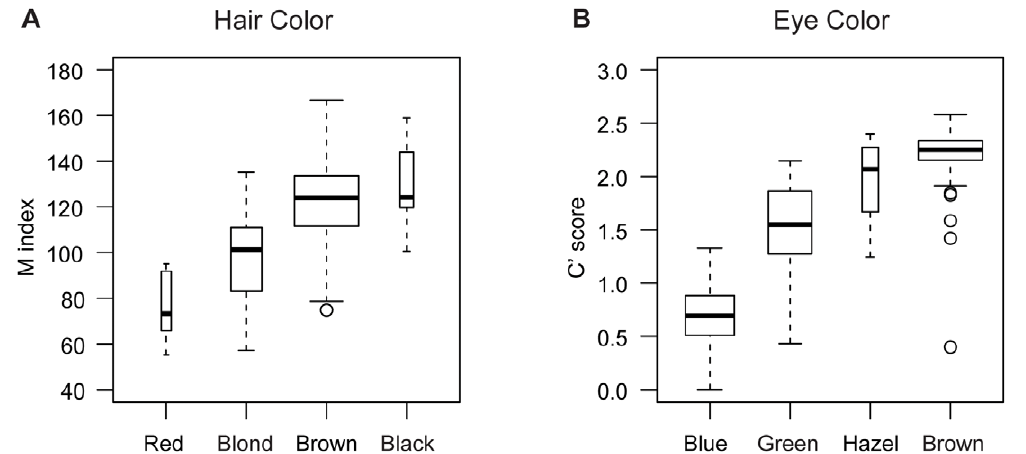
Figure 2. Comparison of measured and self-reported hair and eye color. ( A ) The boxplots of hair pigmentation (M index) binned by self- reported hair color show that there is a good correspondence between categorical hair color and the M index. On average, individuals with red hair color (n=6) have lower M indices than blond individuals (n=58). Individuals reporting brown (n=252) or black (n=11) hair color have the highest M indices. ( B ) Similarly for eye pigmentation, the C’ score corresponds well to the self-reported eye color. Individuals reporting blue (n=123), green (n=97), hazel (n=14), and brown (n=212) eye color have increasing average C’ scores. We note that one individual has a discrepant self-reported color vs. C’ score. This individual self-reported light brown eye color but the C’ score is indicative of most likely blue eye color. This individual was part of the replication cohort and removing the sample from the association study produces similar p-values, only slightly less significant for the OCA2/ HERC2 SNPs. Each box in the plot is drawn with a width proportional to the square root of the sample size.